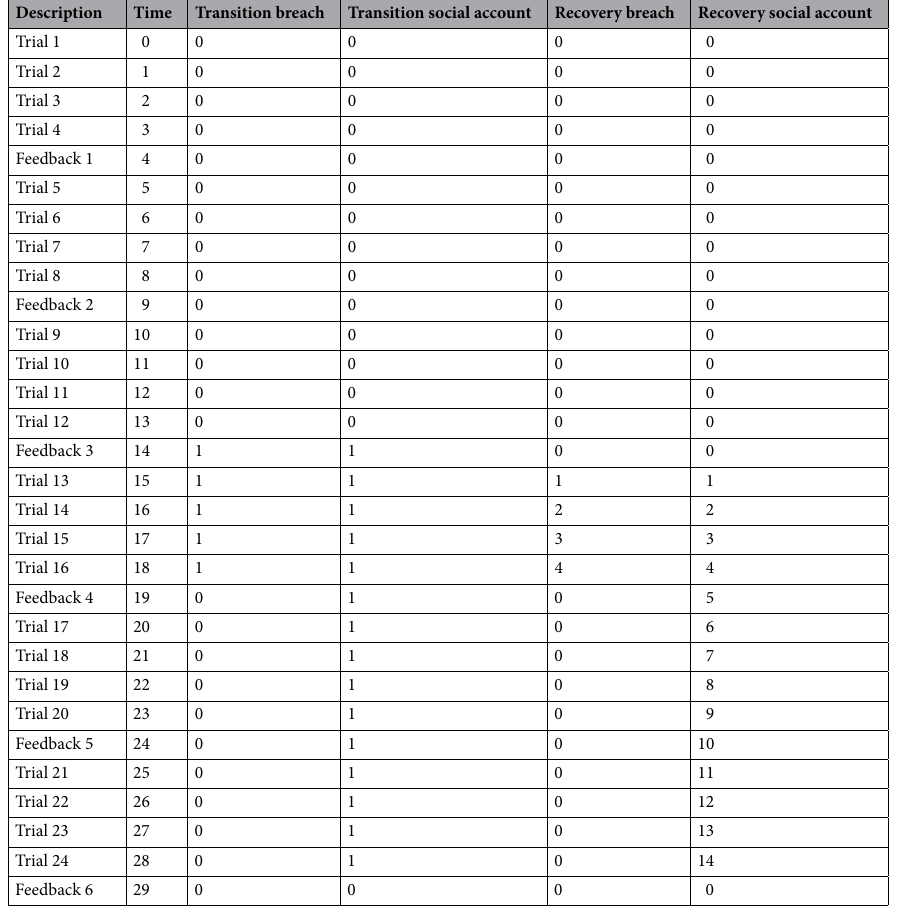
Table 1. Coding of time, transition, and recovery variables for discontinuous random coefficient models. Feedback 3 = Breach manipulation + Prompt social account manipulation, Feedback 4 = Delayed social account manipulation, Feedback 5 = Late social account